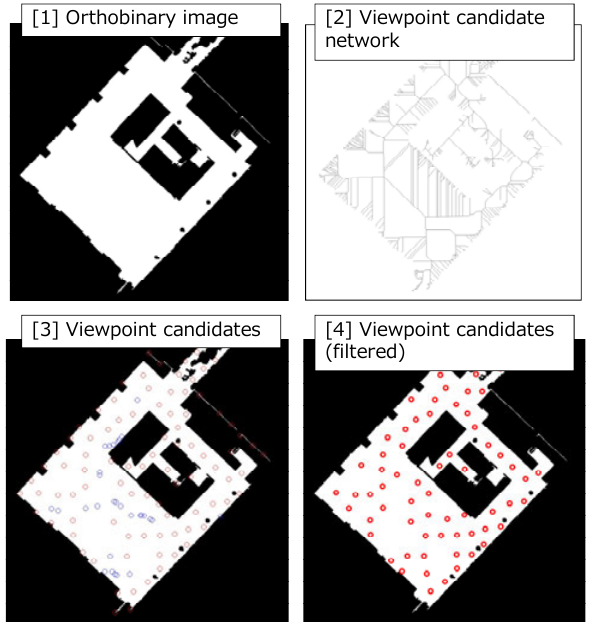
Figure 10. Viewpoint candidates